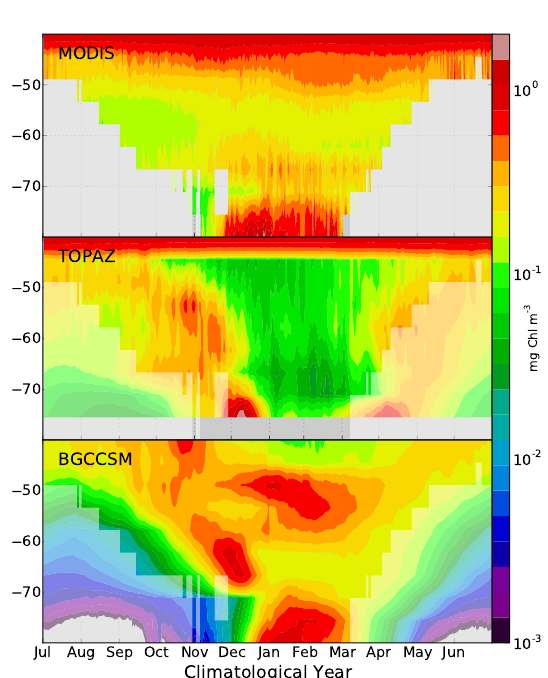
Figure 4. Hofmøller plots of satellite Chl (top panel), Chl simulated by TOPAZ (middle panel), and Chl simulated by BGCCSM (bottom panel) south of Australia. All panels are zonal medians within the box. All data that fall on a specific grid cell on a specific day of the year are averaged to one value.